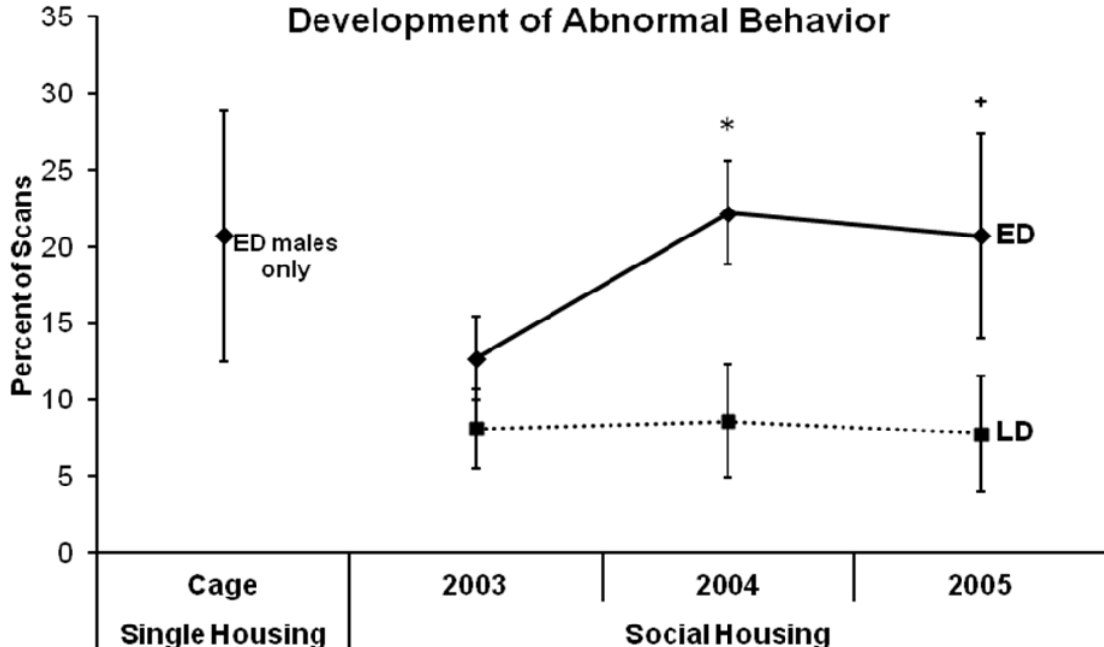
Figure 2. Development of the overall abnormal behavior of early vs. late deprived chimpanzees over the three sample